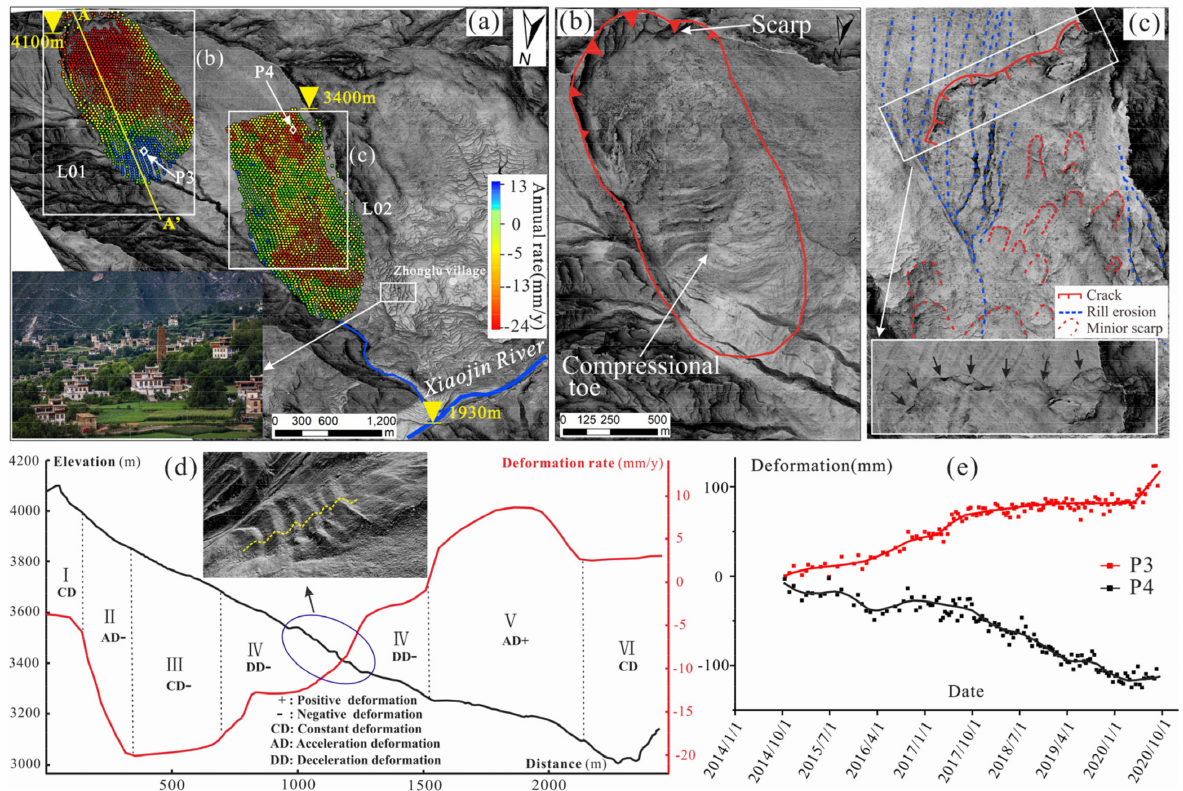
Figure 7. Images of two landslides in Zhonglu Town and the corresponding time-series-deformation analysis: ( a ) InSAR- acquired annual average deformation rate of Landslides L01 and L02 in Zhonglu Town (the lower-left corner shows the Zhonglu Tibetan Village under the slope); ( b ) airborne LiDAR-SVF image of Landslide L01; ( c ) airborne LiDAR-SVF image of Landslide L02; ( d ) topographic profile and deformation rate profile along Line A-A’; ( e ) time-series deformation of Points P3 and